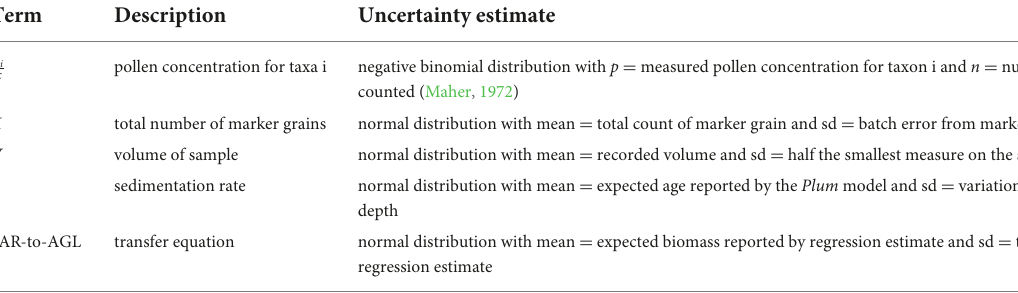
TABLE 1 Uncertainty estimates for the constituent metrics used to calculate tree biomass from pollen accumulation